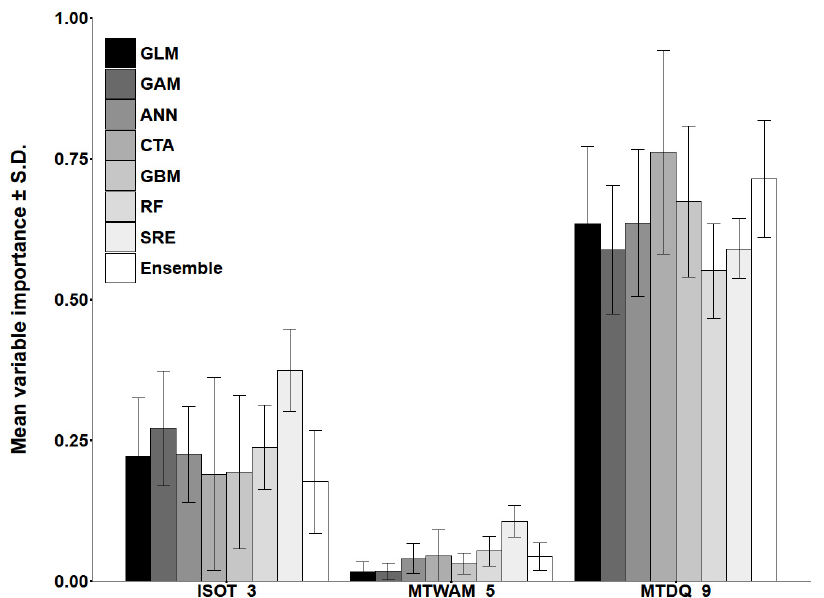
Figure 3. Variable importance scores for predictors used in models for Ips typographus . ISOT_3: isothermality, MTWAM_5: maximum temperature of warmest month, MTDQ_9: mean temperature of driest quarter. GLM: generalized linear model, GAM: generalized additive model, ANN: artificial neural network, CTA: classification tree analysis, GBM: generalized boosting model, RF: random forest, SRE: surface range envelope.